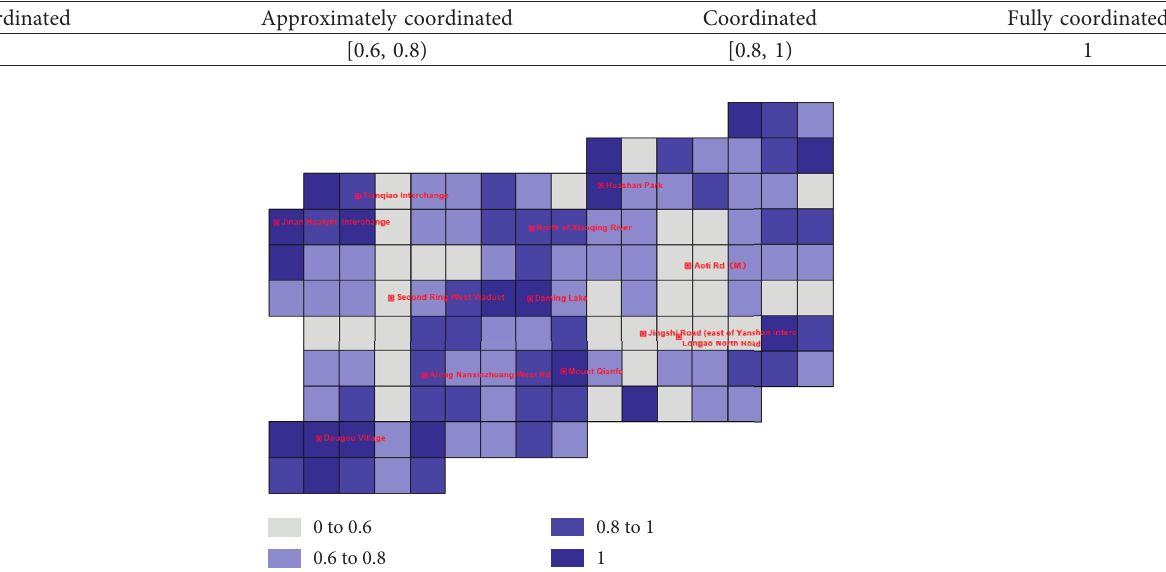
Figure 9: Distribution of coordinated development index θ of built environment to traffic level.